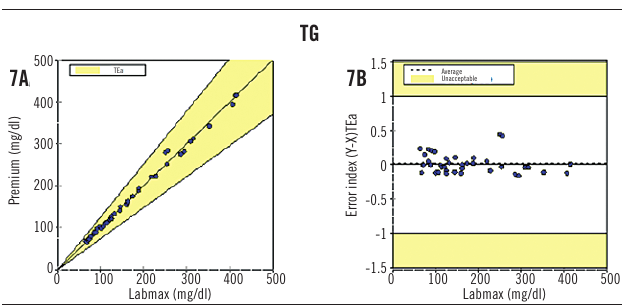
figurE 7 − Comparisons between TG measurement for 2 automated chemistry platforms A) linear regression for TG measurements between Labmax 240 ® (E1) and Labmax 240 Premium ® (E2): n = 40, r = 0.997, p > 0.05; equation for the correlation: E2 = 0.992*E1 + 1.8; TEa = 26%; B) graph comparing the systems Labmax 240 ® (E1) and Labmax 240 Premium ® (E2) for TG measurement: error index = [(result - mean)/TEa] (table of biological variation); results > +1 and < -1 are considered inadequate ( n =